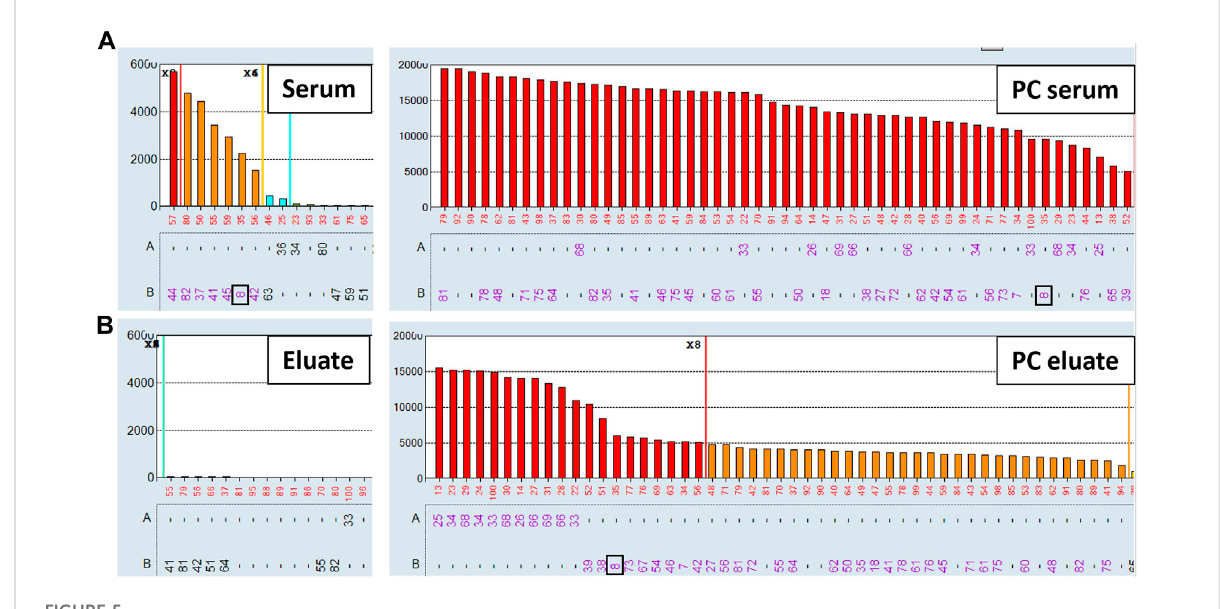
FIGURE 5 Antibodies targeting the 156D denatured epitope are not adsorbed/eluted with the AXE protocol. SAB images of Class I HLA speci fi cities in a patient ’ s serum (A) , (left panel) and the positive control serum (A) , (right panel), as well as AXE eluates from patient ’ s serum (B) , (left panel) and from the positive control serum (B) , (right panel) using HLA-B8 mismatched donor cells are shown.